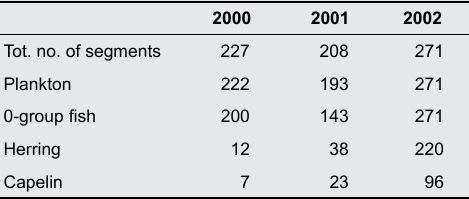
Table 2. Number of cruise line segments with observer activity >0 and prey abundance